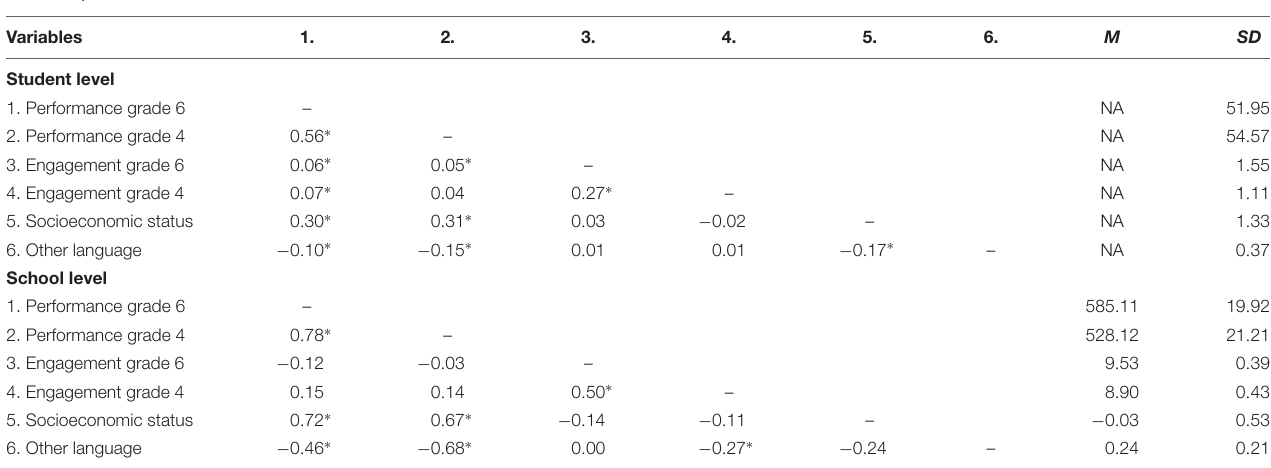
TABLE 3 | Matrix of the zero-order correlation coefficients at the student-level and